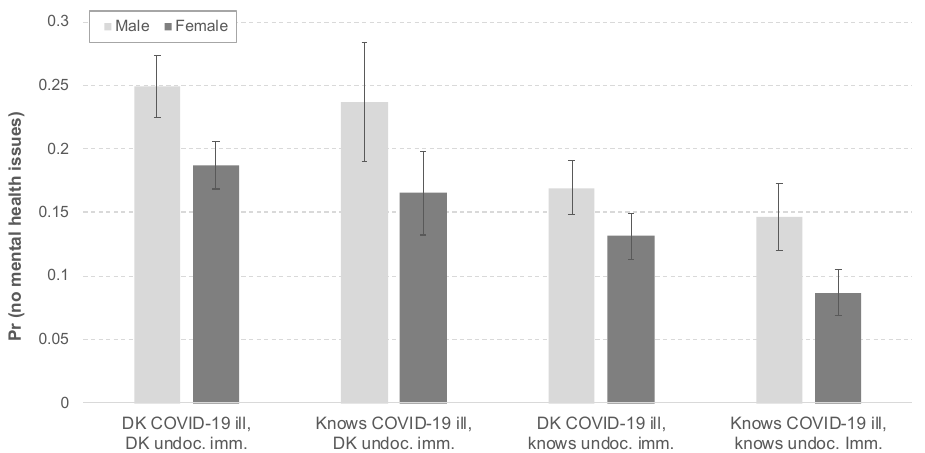
Figure 2. Predicted probabilities of reporting no mental health issues (three-way interaction among gender, knowing someone with COVID-19, and knowing undocumented immigrant). Source: Au- thors’ analysis using the SOMOS COVID-19 Crisis National Latino Survey (2020).